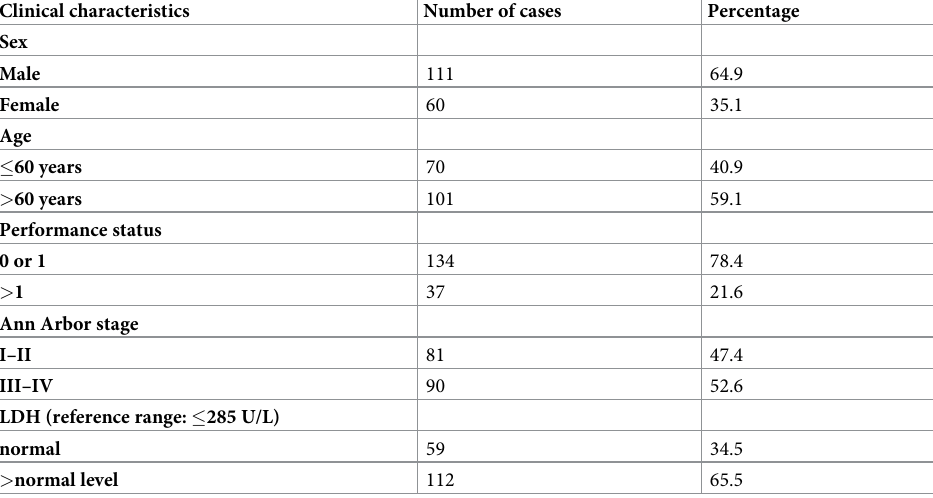
Table 2. Characteristics of the 171 DLBCL